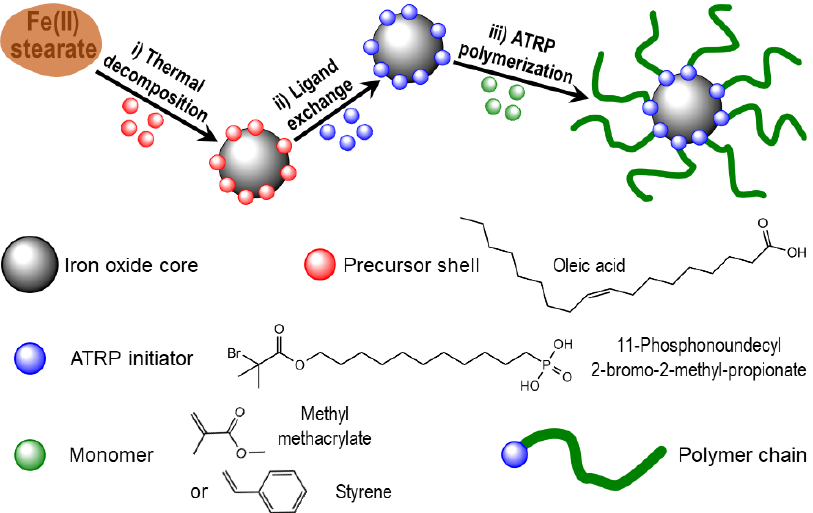
Figure 1. The three steps of the gram-scale synthesis of non-aggregated iron oxide/polymer core-shell nanomaterials.